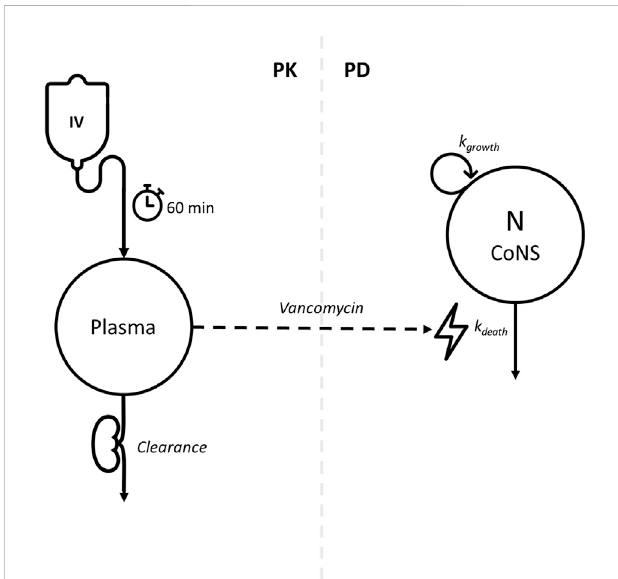
FIGURE 2 Conceptual pharmacokinetic – pharmacodynamic model for vancomycin effect on bacterial DNA load. Left side of the dashed line: one-compartment PK model. Vancomycin is infused intravenously for 1 h and is renally cleared from the body. Right side of the dashed line:empiricalturnoverPDmodel.ThenumberofCoNS(N)hasanatural in vivo multiplication rate of k growth and natural cell death rate of k death . The vancomycin concentration in plasma has a bactericidal action by stimulation of k death , depicted by the dashed arrow connecting the left and right sections of the fi